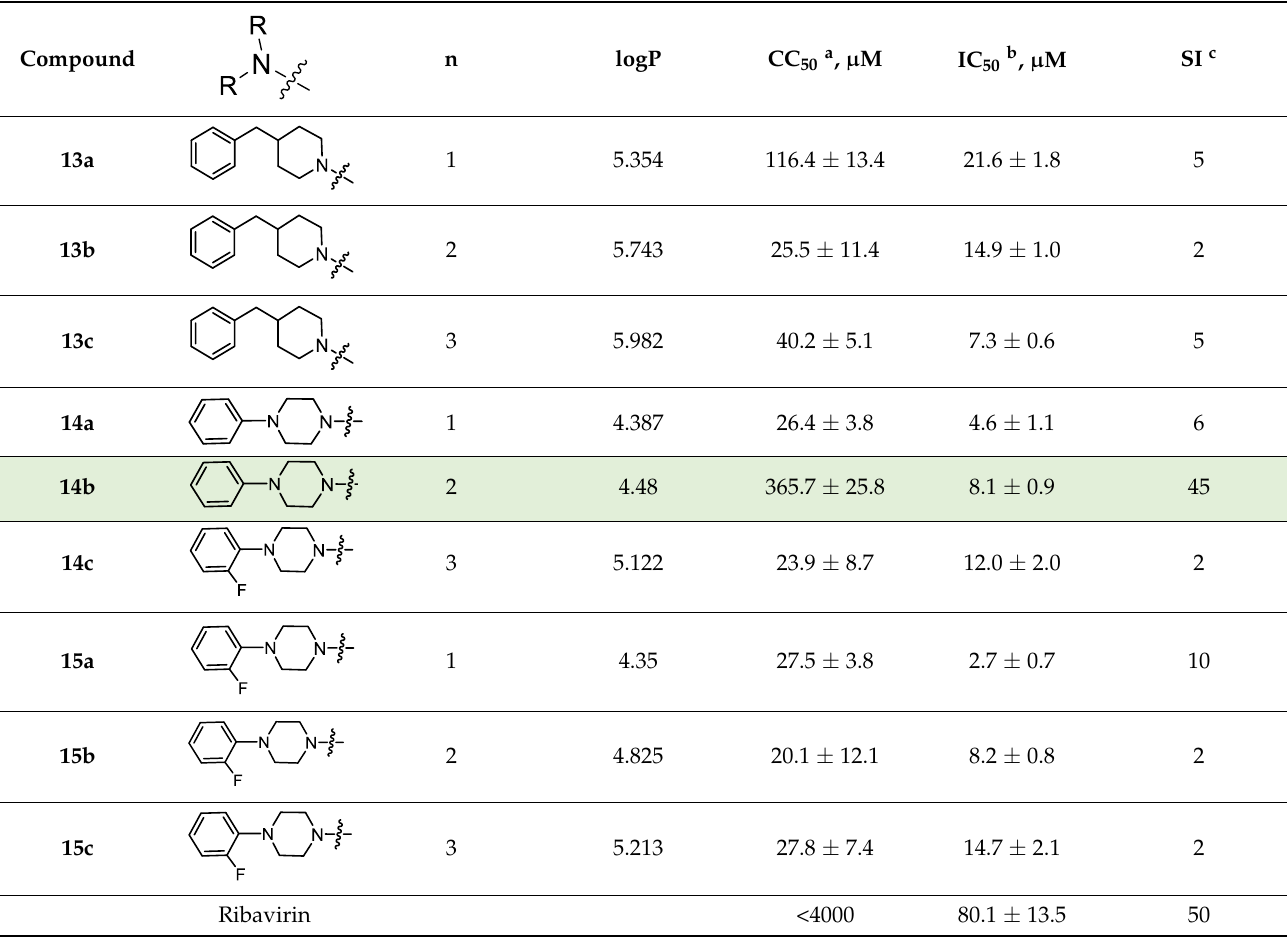
Table 2. Cont. Table 2. In vitro anti-RSV activity, cytotoxicity, and logP values for compounds 3 – 15a – c